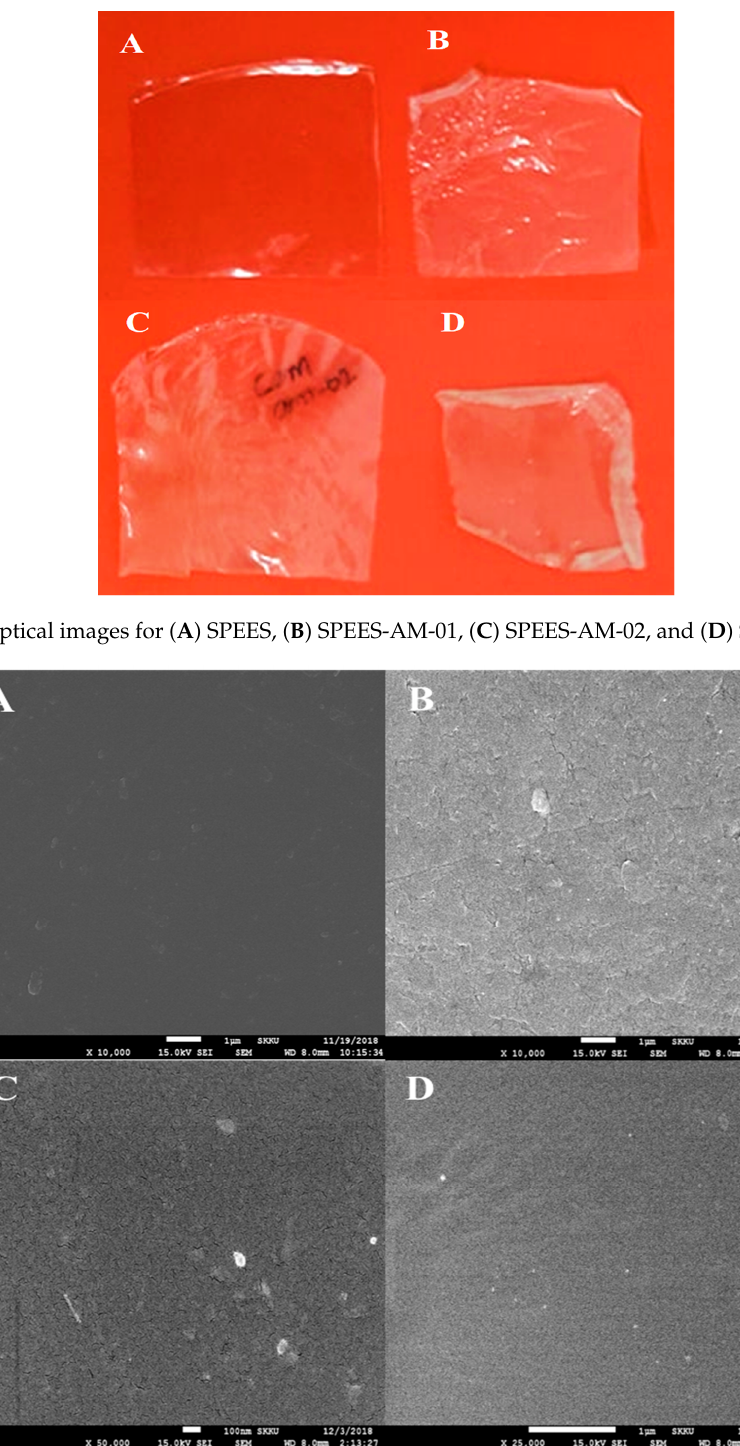
Figure 4. FE-SEM for ( A ) SPEES, ( B ) SPEES-AM-01, ( C ) SPEES-AM-02, ( D ) SPEES-AM-03.